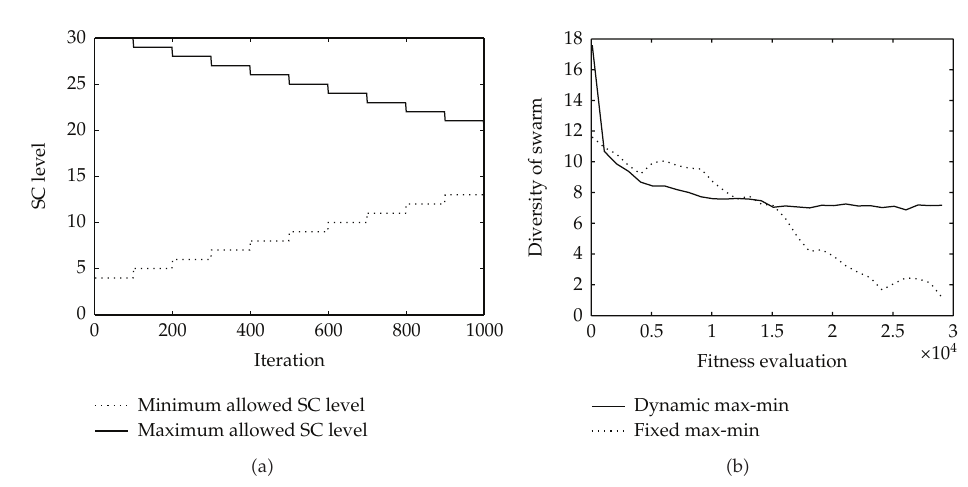
Figure 7: The allowed SC number and the e ff ect on the swarm